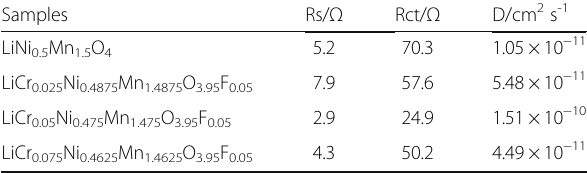
Table 2 Fitting parameters of the Nyquist plots for the samples